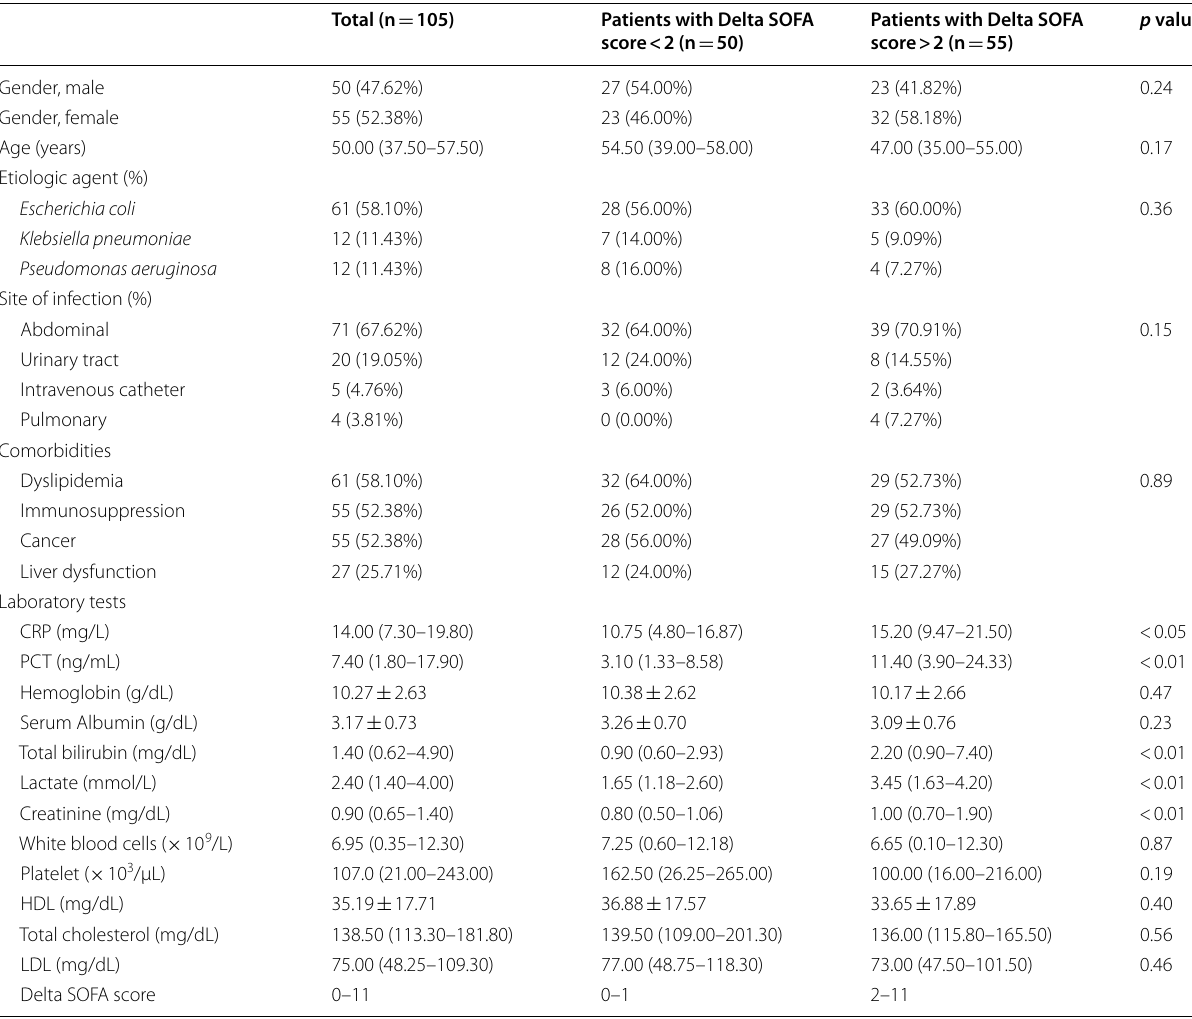
Table 1 Demographic, clinical and laboratory parameters of